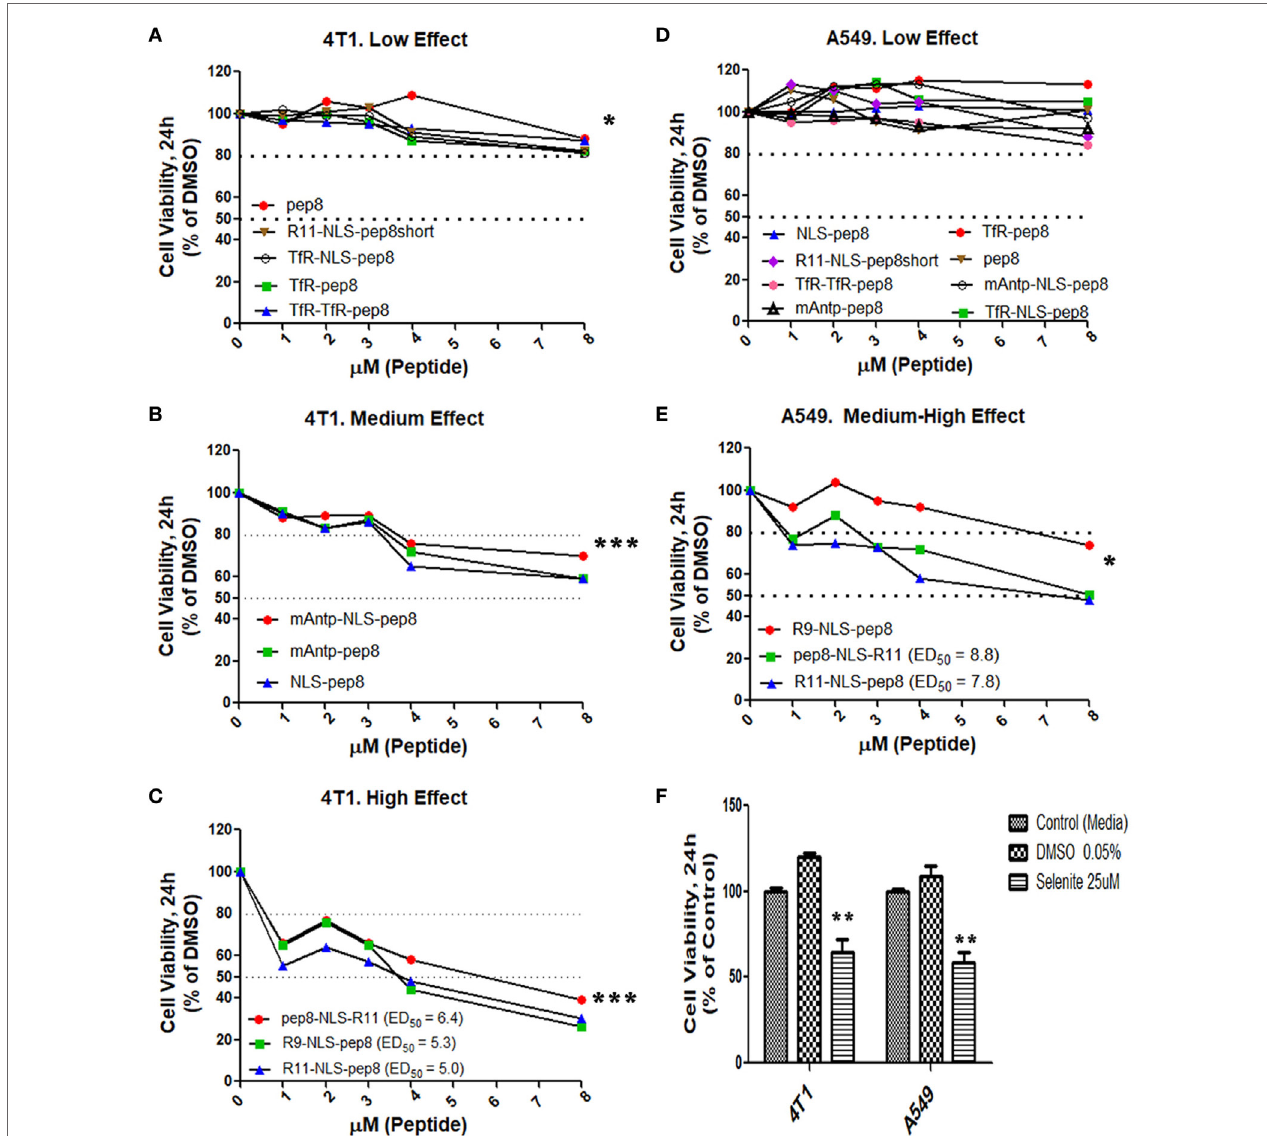
FigUre 2 | Cell viability screening of cell-penetrating peptides (CPPs) NKp44-derived pep8 (NKp44-pep8) chimeras using PrestoBlue based cell viability assay. Mouse 4T1 breast cancer and human A549 lung cancer cell lines were used for screening different CPP fused to NK44-derived pep8 and their effect on cell viability in a PrestoBlue assay. The results are shown in respect to the basal viability indicated using equivalent % DMSO (background). CPPs-NKp44-pep8 were divided according to their effect on cell viability and the cancer model. (a) 4T1: low effect (** p , group at 8 µM), (B) 4T1: medium effect (*** p , group at 8 µM), (c) 4T1: